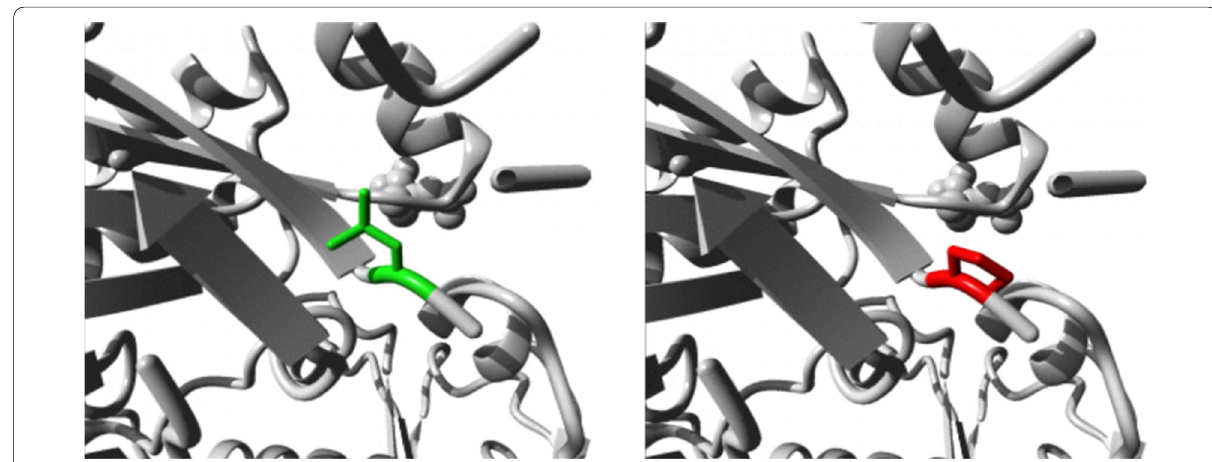
Fig. 2 The three‑dimensional model of the protein with close‑up of the mutation. The protein is colored gray, and the side chains of both the wild‑type and the mutant residue are shown and colored green and red, respectively